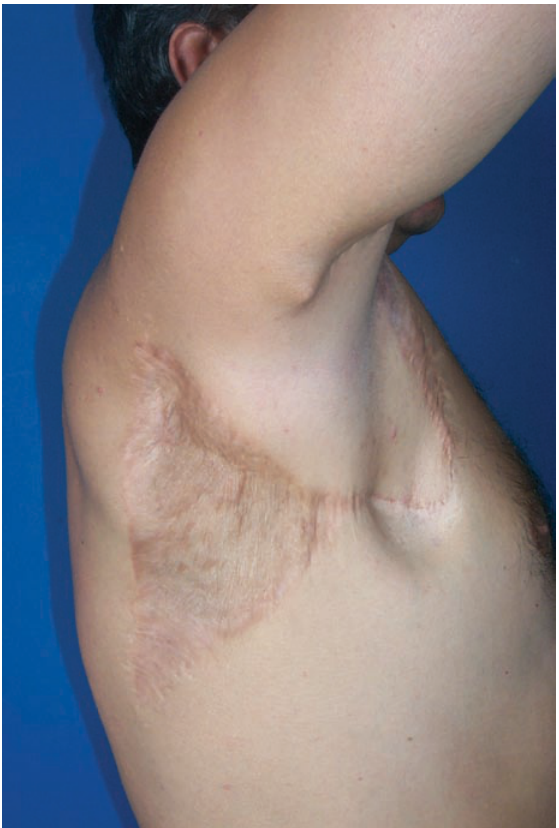
with a transposition